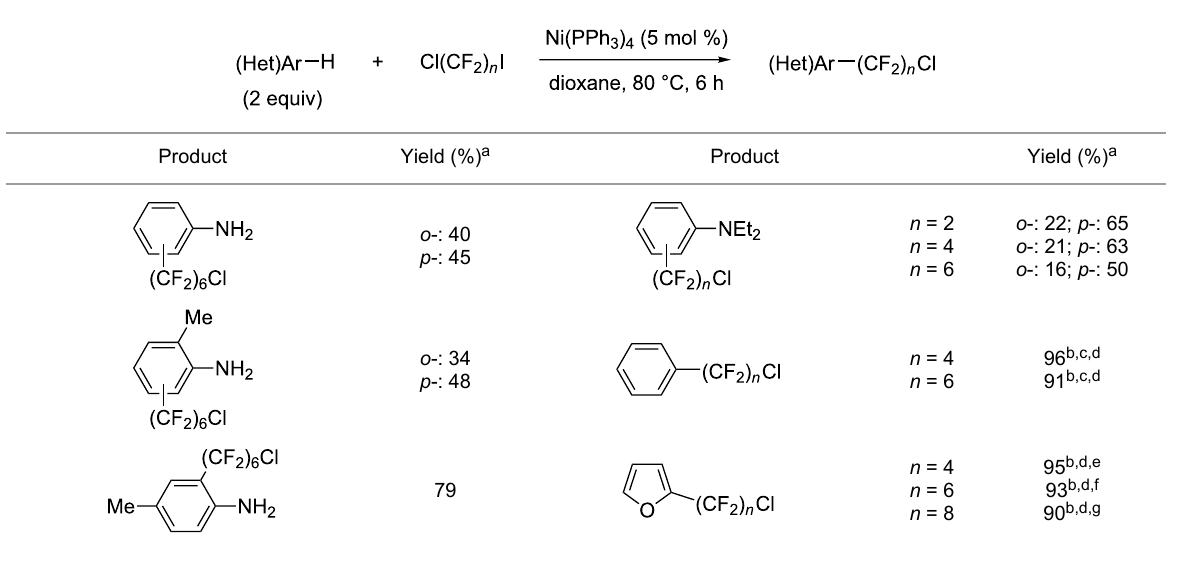
Table 35: Ni-catalyzed perfluoroalkylation of anilines, benzene, furan, thiophene and pyrrole using ω -chloroperfluoroalkyl iodides